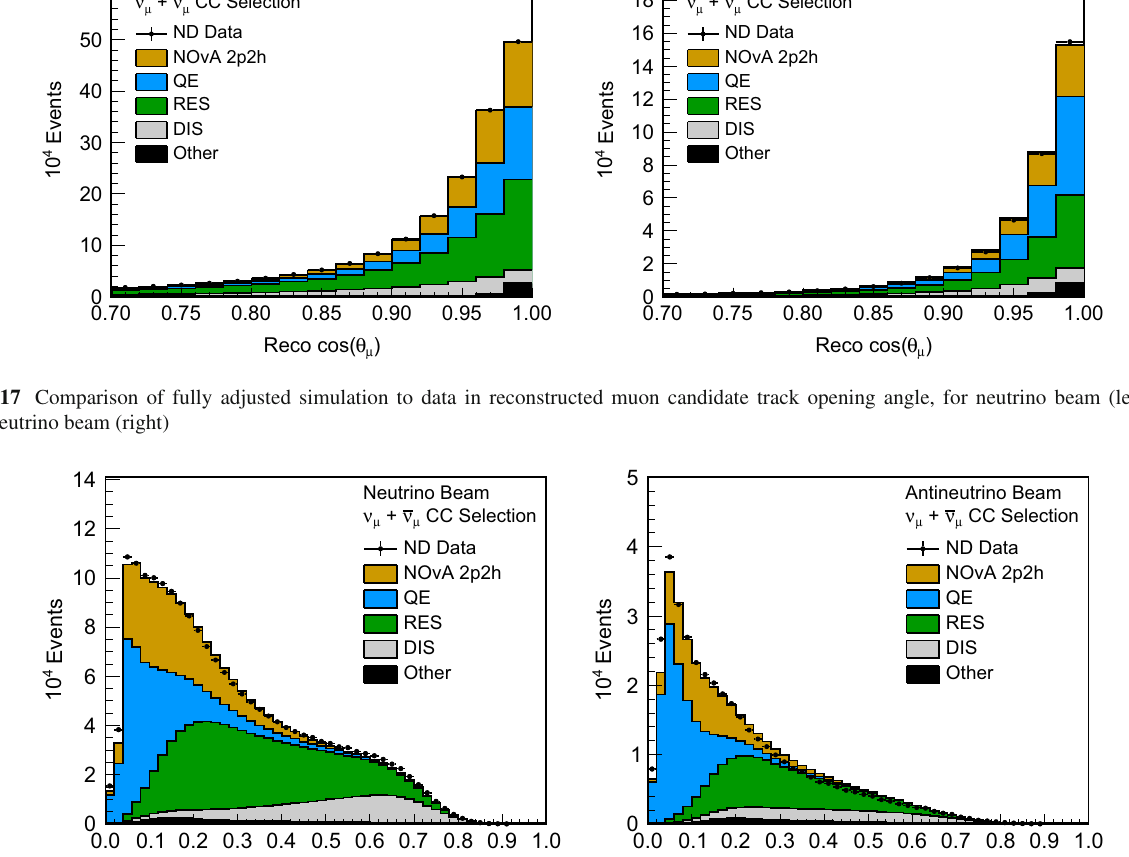
0.0 0.1 0.2 0.3 0.4 0.5 0.6 0.7 0.8 0.9 1.0